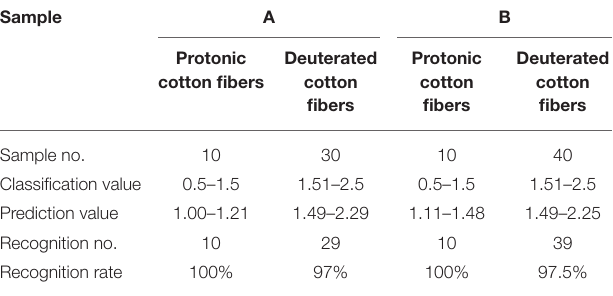
TABLE 5 | Classification result of partial least squares regression (PLS) models [cross-validation, A: high deuteration rate (20–60%) fibers and protonic fibers; B: high and low deuteration rate (1–60%) fibers and protonic